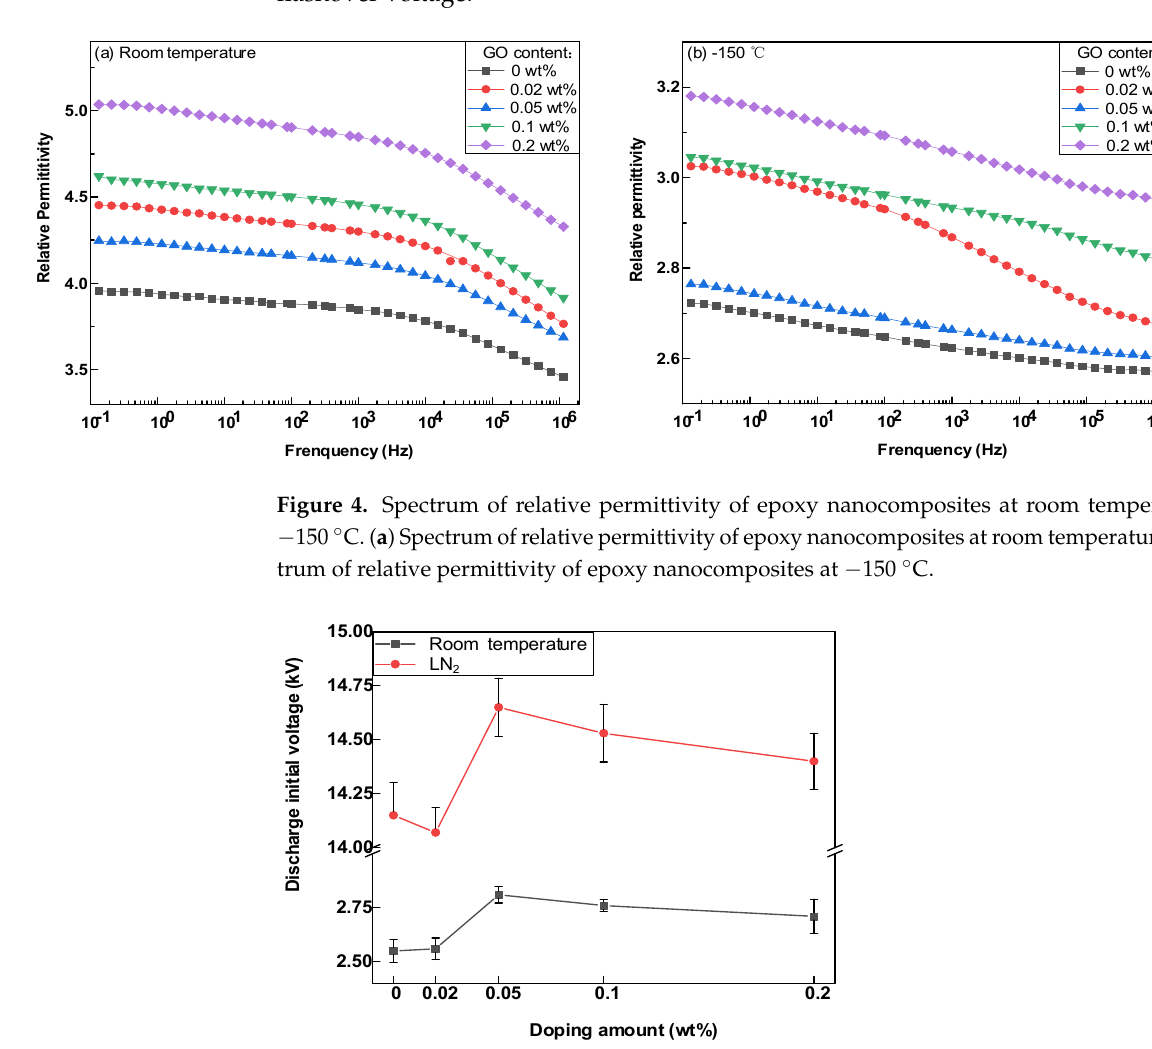
Figure 4. Spectrum of relative permittivity of epoxy nanocomposites at room temperature and − 150 °C. ( a ) Spectrum of relative permittivity of epoxy nanocomposites at room temperature; ( b ) Spec- trum of relative permittivity of epoxy nanocomposites at − 150 °C .